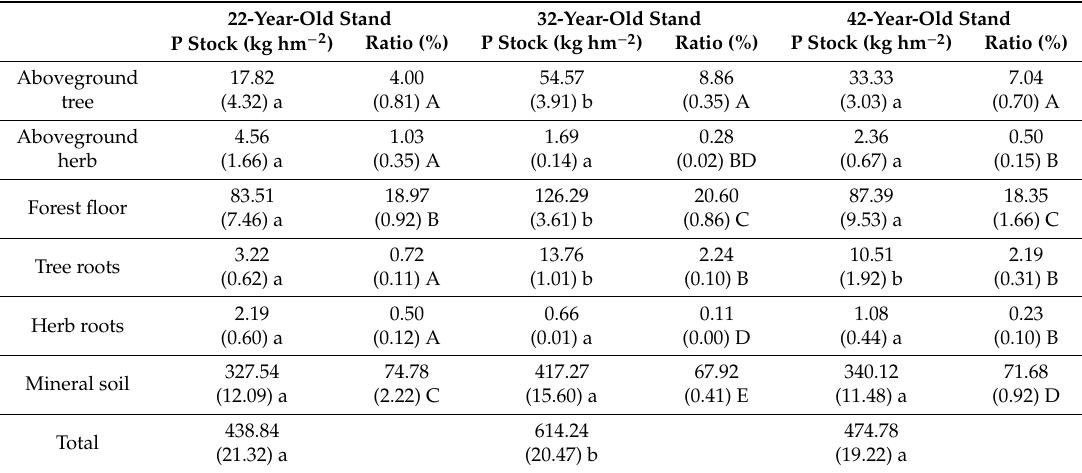
Table 7. The P Stocks of di ff erent components and their contributions to the total ecosystem P pool in three di ff erent aged